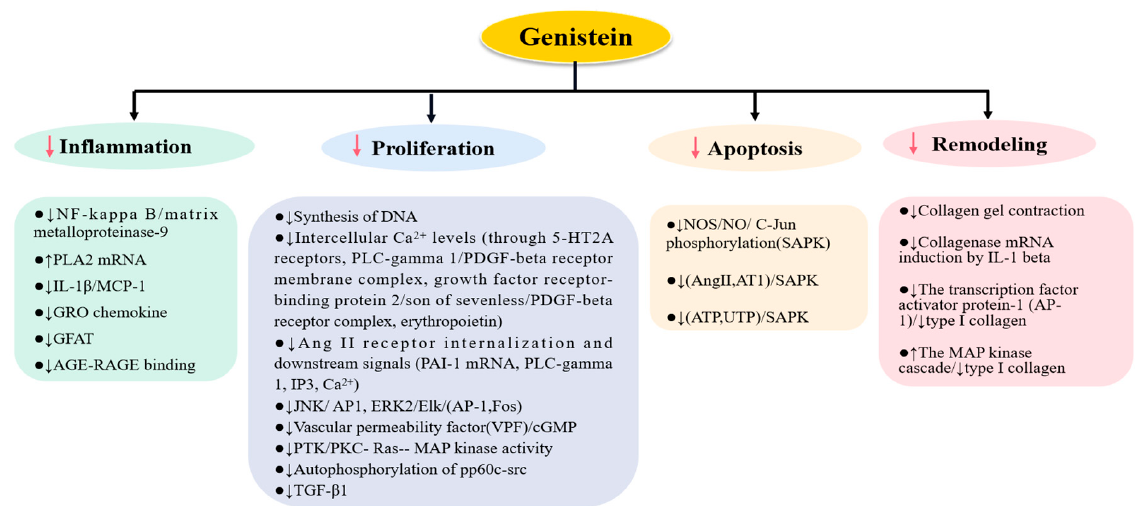
Figure 1. The effects of genistein on mesangial cells. NF- κ B: nuclear factor NF-kappaB; PLA2: phos-